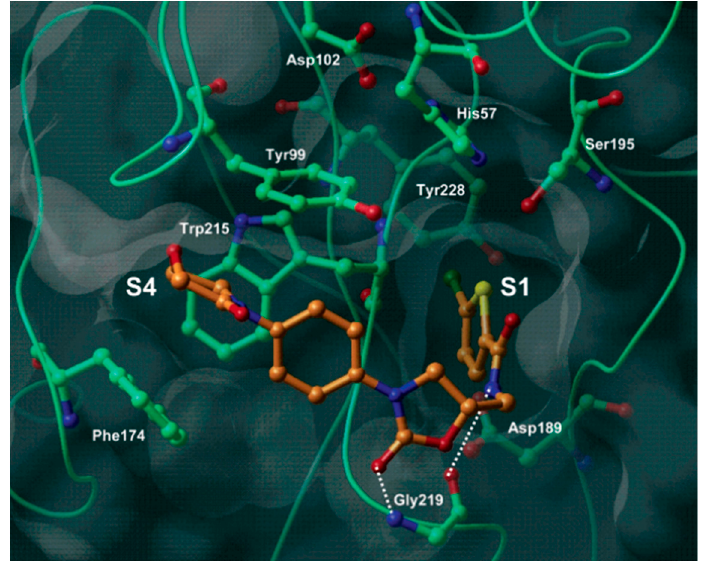
Figure 2. X-ray crystal structure of rivaroxaban in complex with human FXa.